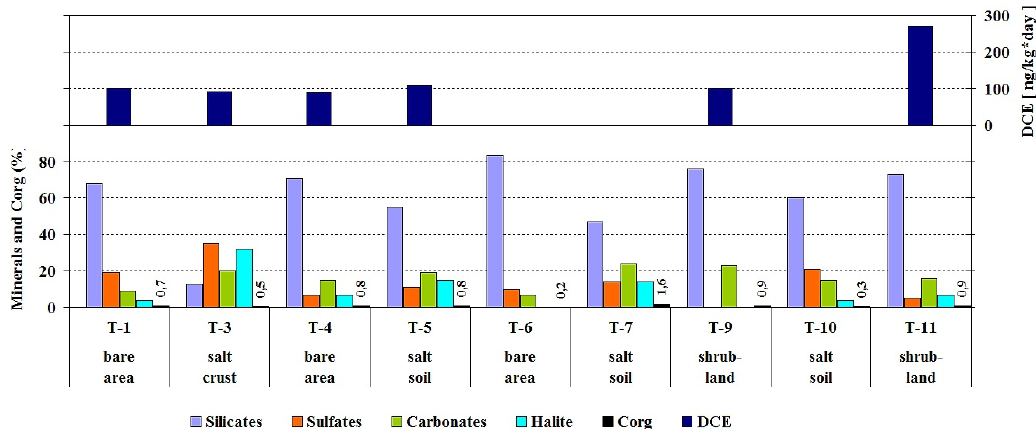
Fig. 4. Mineral content and C org versus DCE production. Samples of topsoil layer 0–2cm (including crusts), incubated for 24h after adding water. DCE determination by purge & trap headspace GC-MS. Production rates are given in [ngkg − 1 * day]. Land cover classes of location T1 till T11 are classified through MODIS time series analysis (see Table 1). C org values are given as numbers